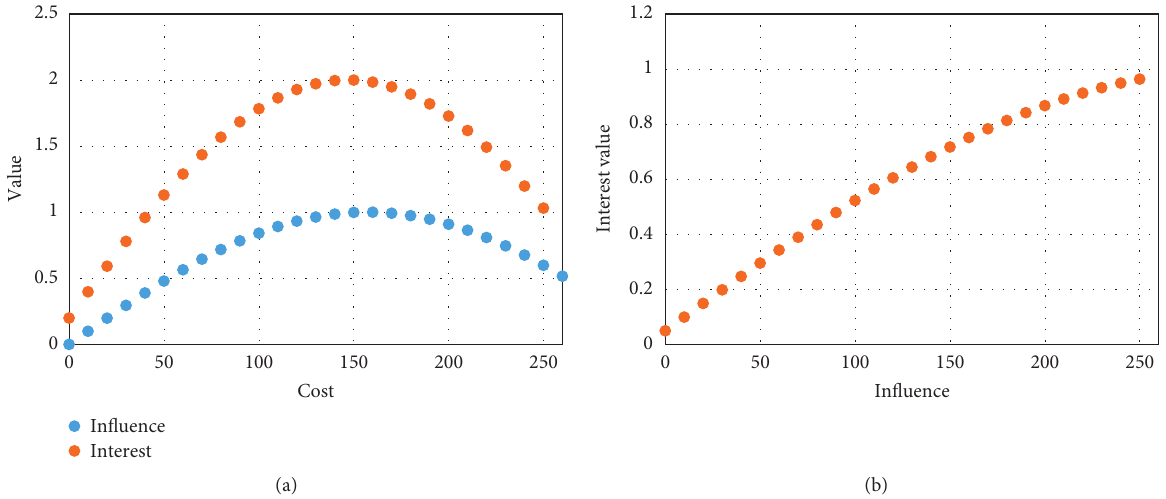
Figure 4: Planar projection of the multiobjective solution. (a) Cost compared with influence and interest. (b) Influence compared with